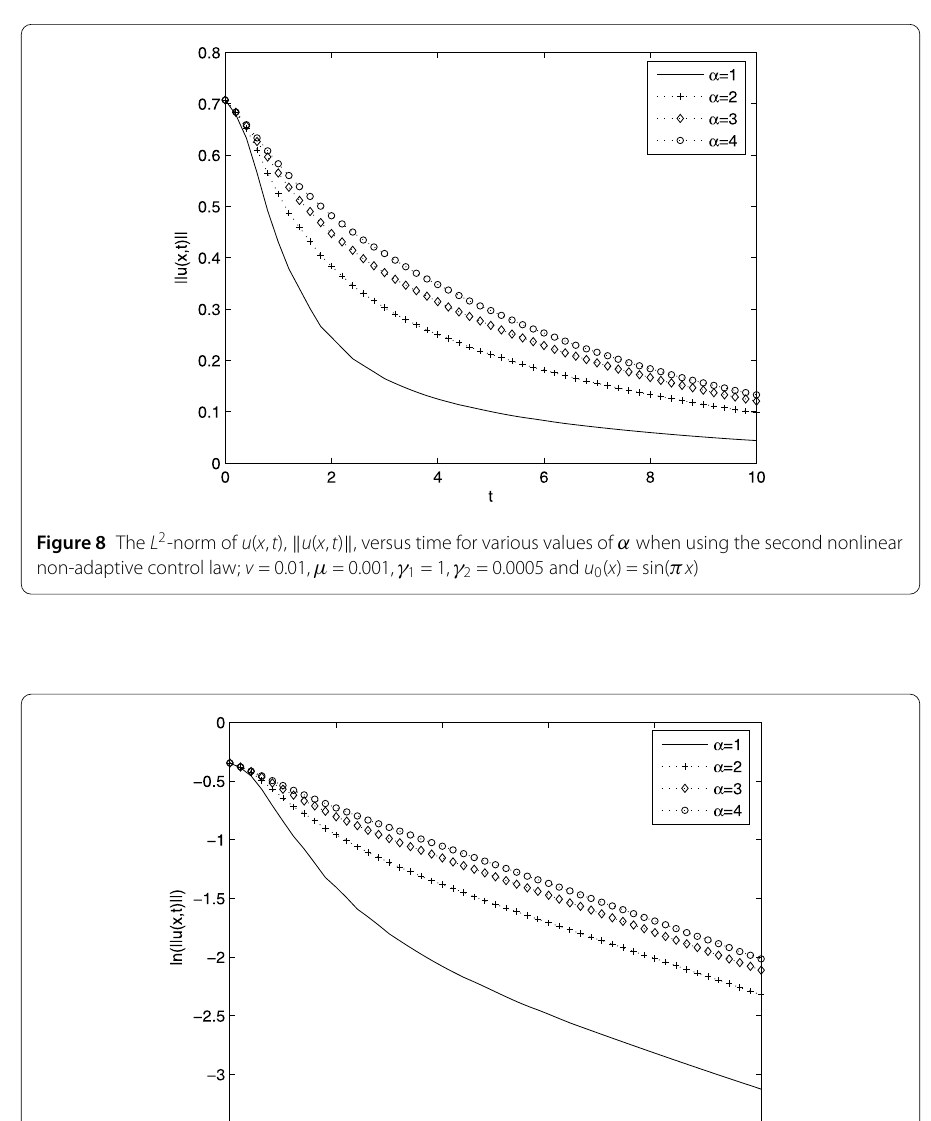
– ν = –0.01, and this is in accordance with the analytical results given by inequality